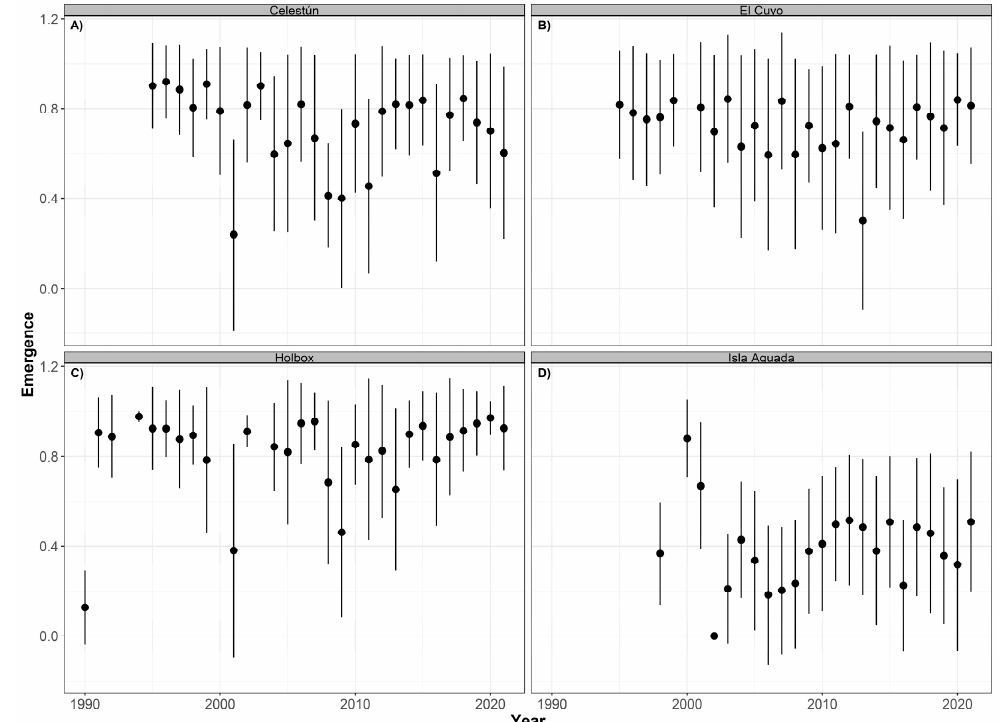
Figure 9. Time series of emergence success (annual mean ± SD) for hawksbill turtles ( Eretmochelys imbricata ) nesting at Celestún ( A ), El Cuyo ( B ), Holbox ( C ), and Isla Aguada ( D ) from 1990 to 2021.